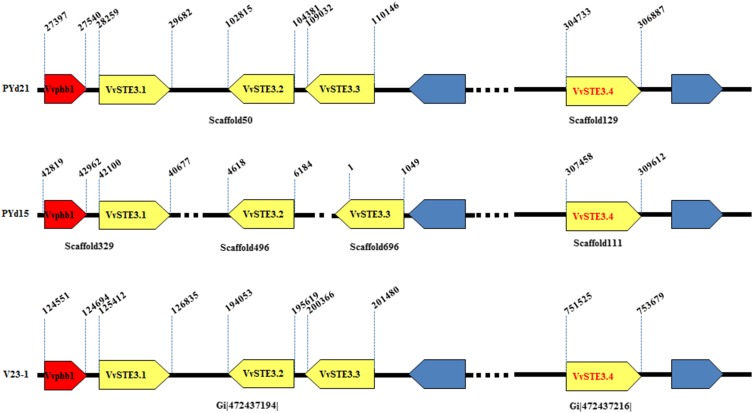
Overview of the MAT-B genes and pheromone receptor like genes of V. volvacea PYd21, PYd15, and V23-1. Pheromone precursor genes are indicated in red, pheromone receptor (like) genes in yellow (the new and fourth STE3 gene has red text), and other genes in blue. Relative positions of the genes on their corresponding genome scaffolds are indicated by black numbers showing the start and stop position of each gene. Corresponding scaffold numbers are indicated under the genes for each respective genome.